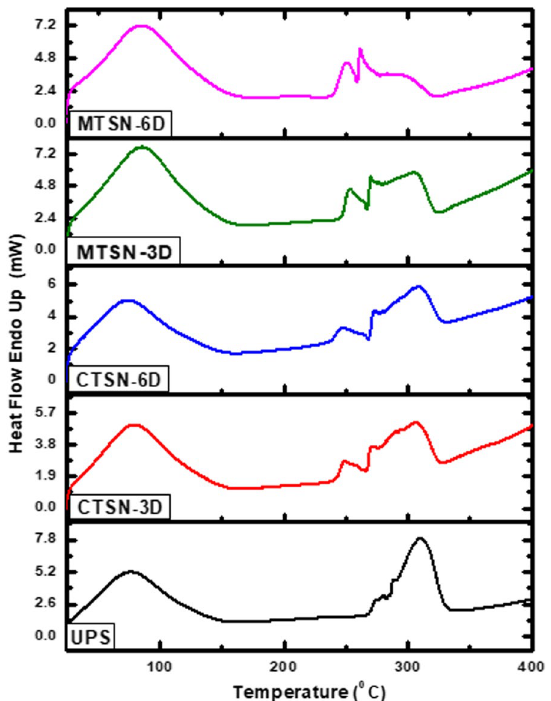
Fig. 2 The DSC thermograms for UPS, CTSN-3 days, CTSN-6 days, MTSN-3 days, and MTSN-6 days obtained during heating ranging from 25 to 400 °C at a heating speed of 10 °C/min. The evaluation of the differential scanning calorimetry (DSC) thermogram of untreated potato starch (UPS) versus chemically treated starch nanoparticle (CTSN) and mechanically treated starch nanoparticle (MTSN)